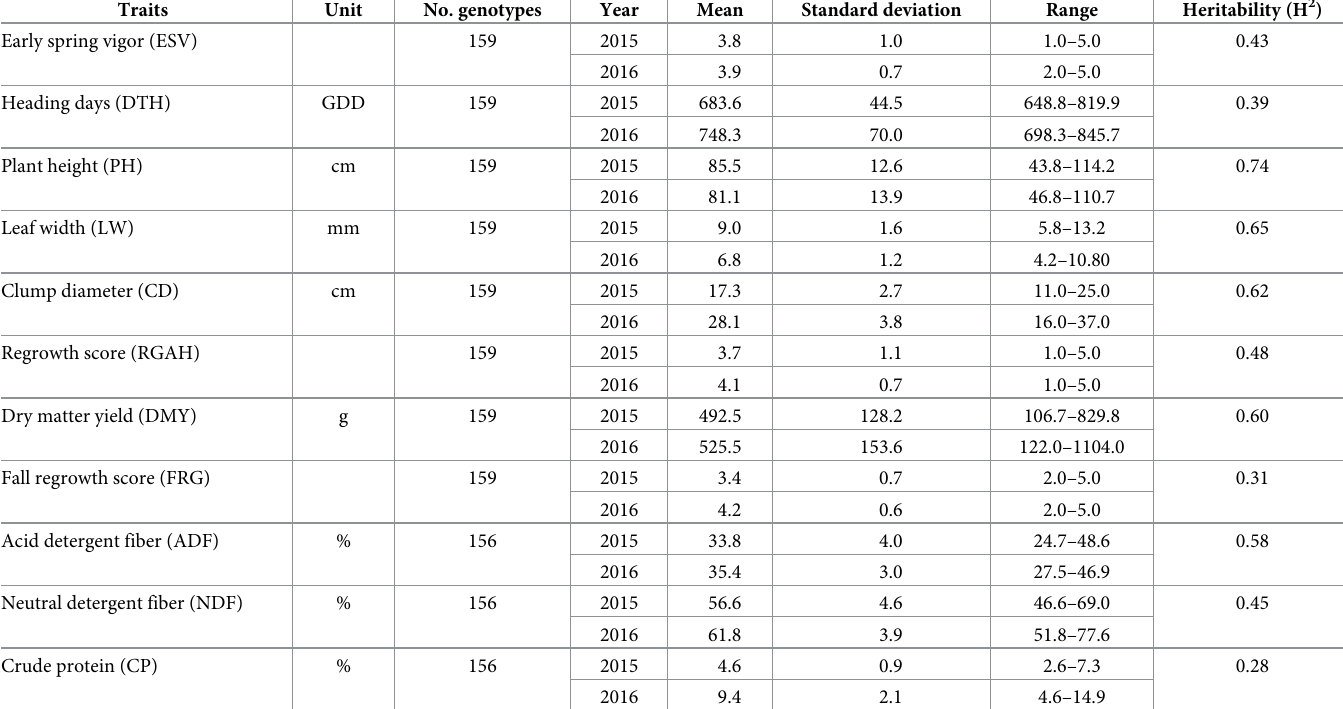
Table 4. Statistics for the distributions of eight agro-morphological and three nutritive values traits, and estimated broad-sense heritability on genotype-mean basis for crested wheatgrass evaluated in two summers at Swift Current, Canada. Traits